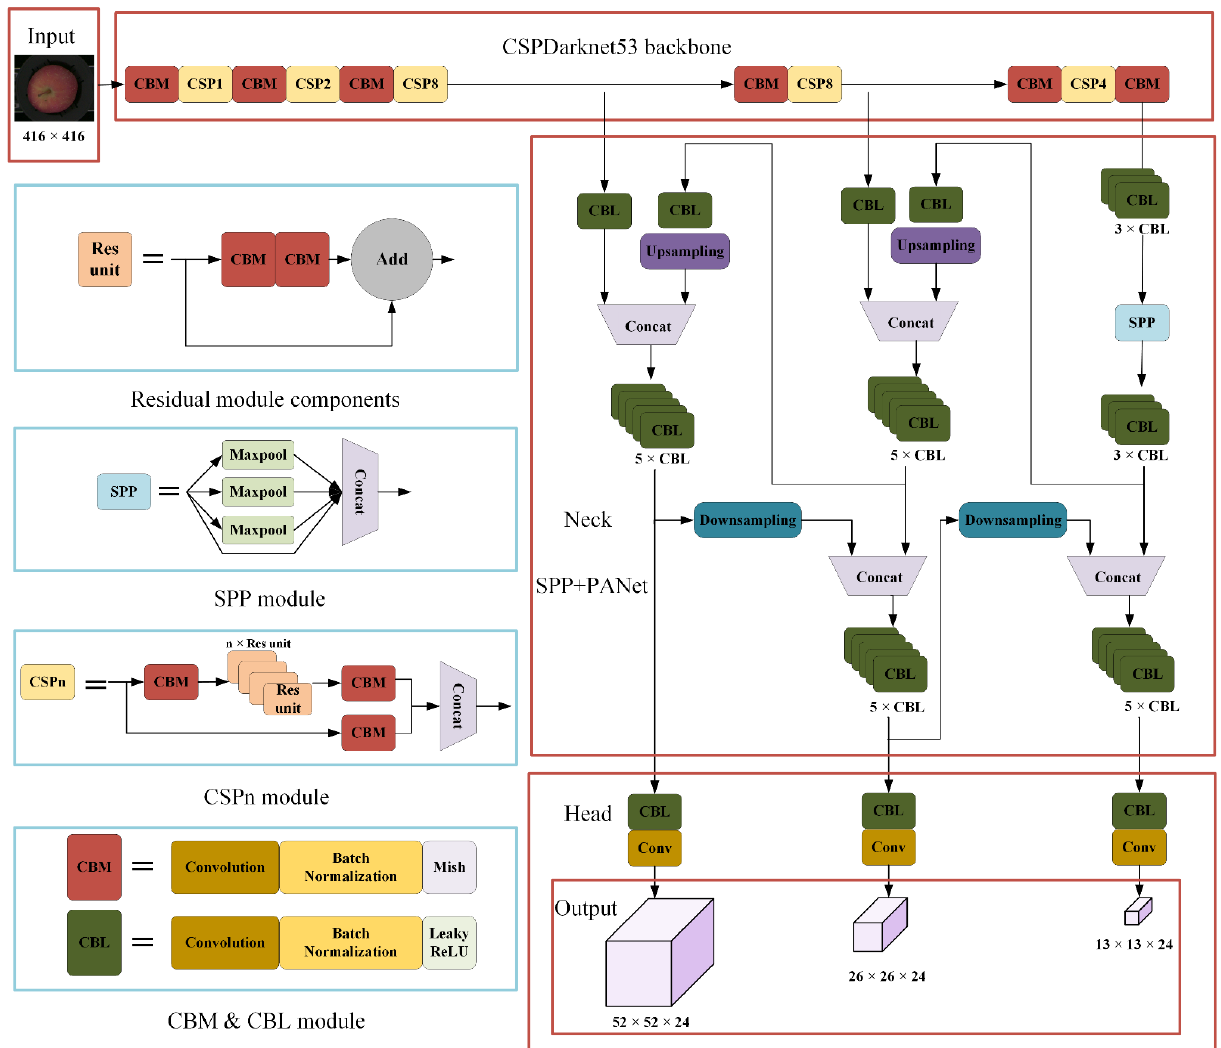
Figure 3. The architecture of YOLO V4 network.